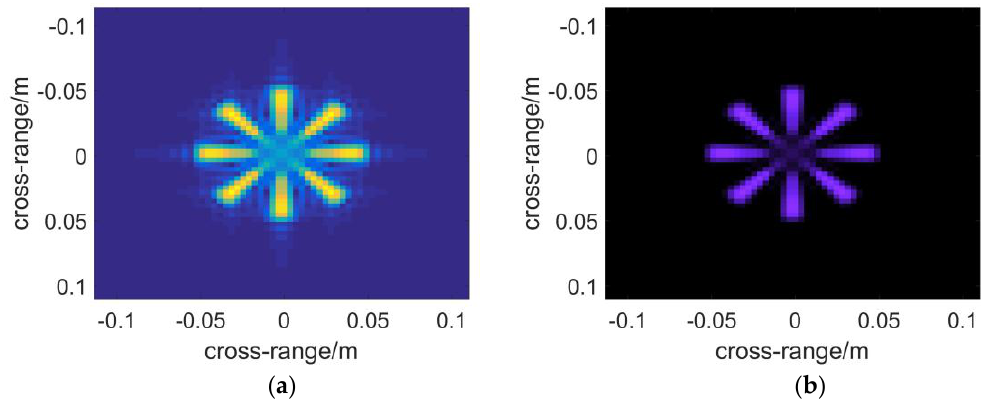
Figure 10. PMA applied to electromagnetic field simulation in the multistatic antenna array case: ( a ) the slice figure; ( b ) 3-D reflectivity figure.